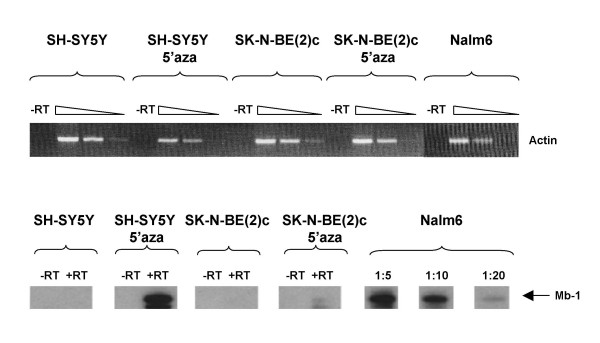
Disruption of the chromatin structure allows for the activation of mb-1 transcription in neuroblastoma cells. (A) The top part of the figure shows ethidium bromide stained agarose gels with actin expression after RT-PCR analysis of Nalm6, SH-SY5Y and SK-N-BE(2)c cells without or after treatment with 5-azaC and TSA. Serial dilutions using 1, 1/5 and 1/25 of the template cDNA after 25 cycles of PCR were used. Panel (B) display auto-radiograms of southern blot analysis of mb-1 RT-PCR products obtained from untreated or 5-azaC/TSA treated SH-SY5Y and SK-N-BE(2)c cells and a serial dilution of untreated Nalm6 cells after 30 cycles of PCR as indicated.